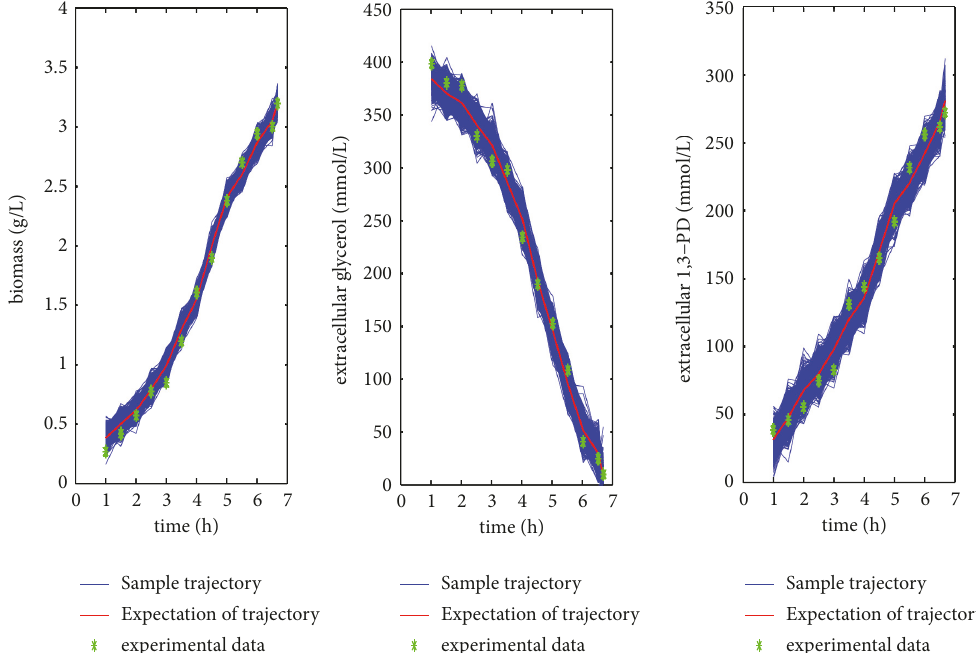
Figure 3: The results of initial glycerol concentration of 402.9348 𝑚𝑚𝑜𝑙/𝐿 and biomass concentration of 0.173 𝑔/𝐿 with 1000 sample trajectories.